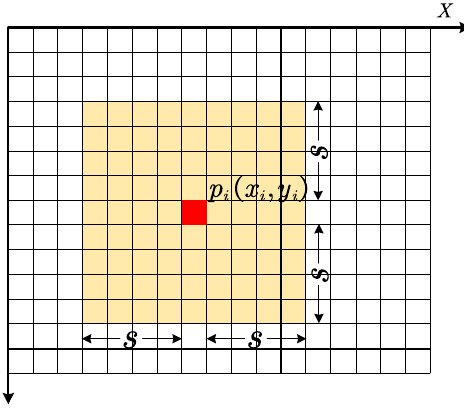
Figure 6. The sketch map of the adaptive threshold segmentation. Suppose that parameter s (see Figure 6) and parameter t (the value of t is greater than 0 and less than 1) represents the background radius and the segmentation coefficient, respectively; then, the sum of pixel gray values in the rectangular area with P i as the center and 2 s + 1 as the side length is determined by Equation At this point, the gray value of a pixel after adapting adaptive threshold segmenta- tion is determined by Equation (19).